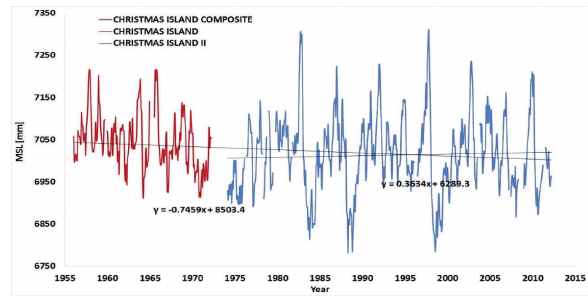
Fig. 2: Christmas Island, Christmas Island II and Christmas Island composite tide gauges (data from